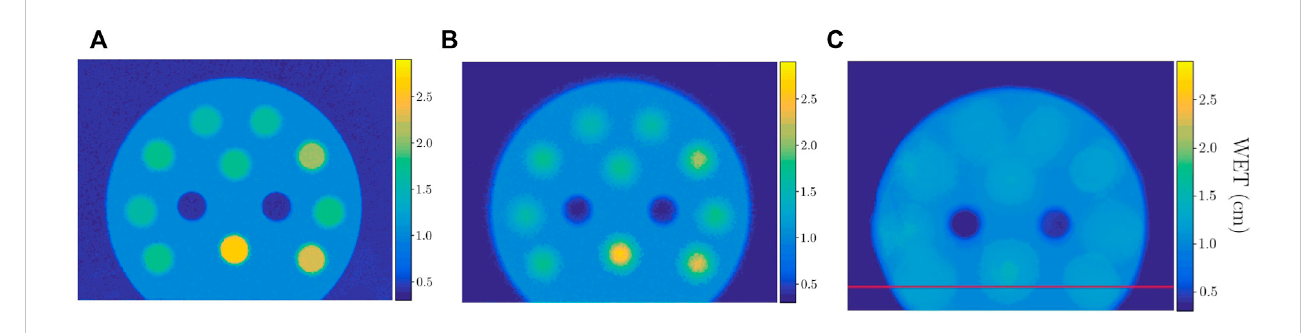
FIGURE 8 WETradiographiesatCALwith (A) 3 mm, (B) 13 mm,and (C) 33 mmphantom-to-detectordistances(lefttoright).Theredlineontherightmarkstheline pro fi les in Figure 9.